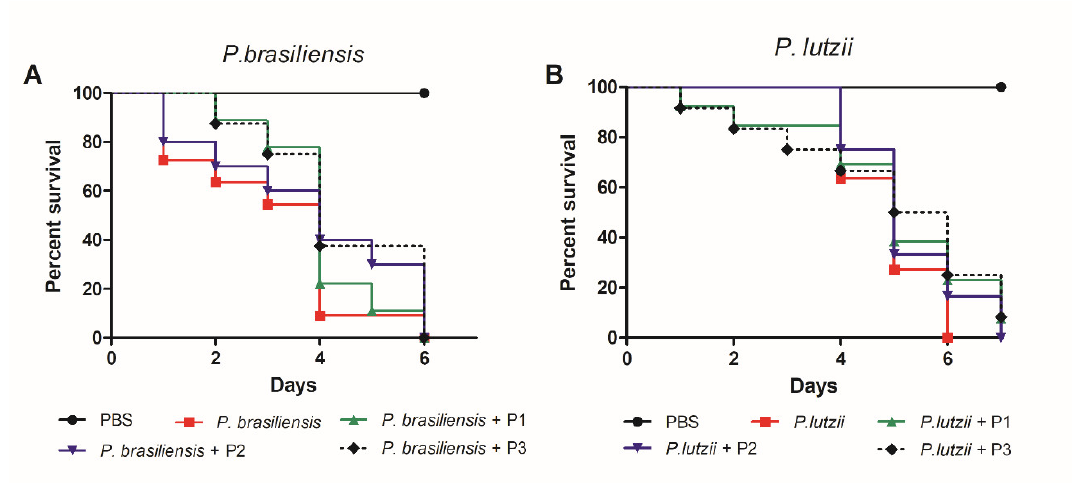
Figure 6. Survival curve of G. mellonella treated with immunogenic peptides at a concentration of 100 µg/larva at 3 h before the infection with P. brasiliensis ( A ) or P. lutzii ( B ). Log-rank test (Mantel–Cox) of eight to 10 biological replicates and three independent experiments ( p < 0.05).